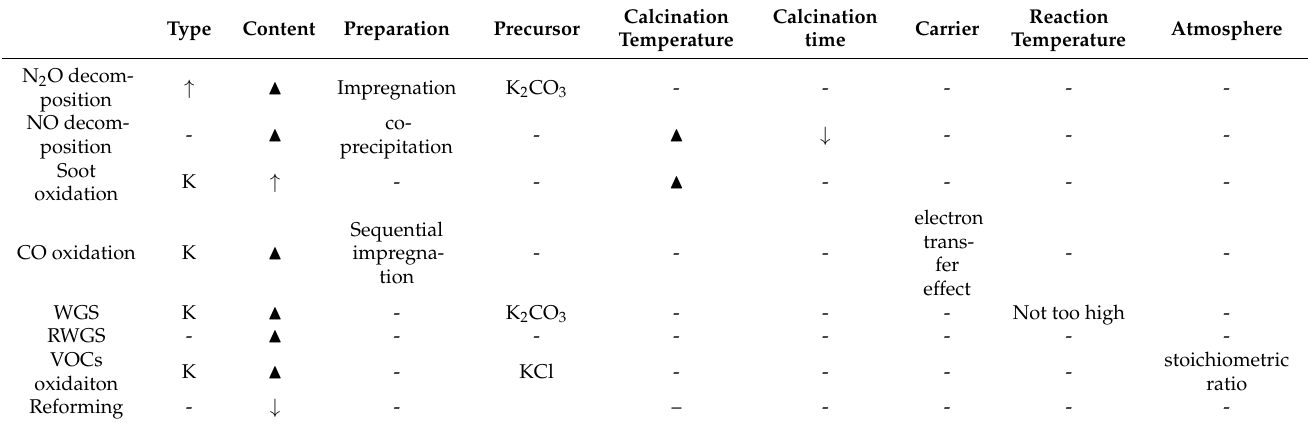
↑ This symbol represents a positive correlation between activity and factor. ↓ This symbol represents a negative correlation between activity and factor. (cid:78) This symbol represents a volcanic type relationship between activity and